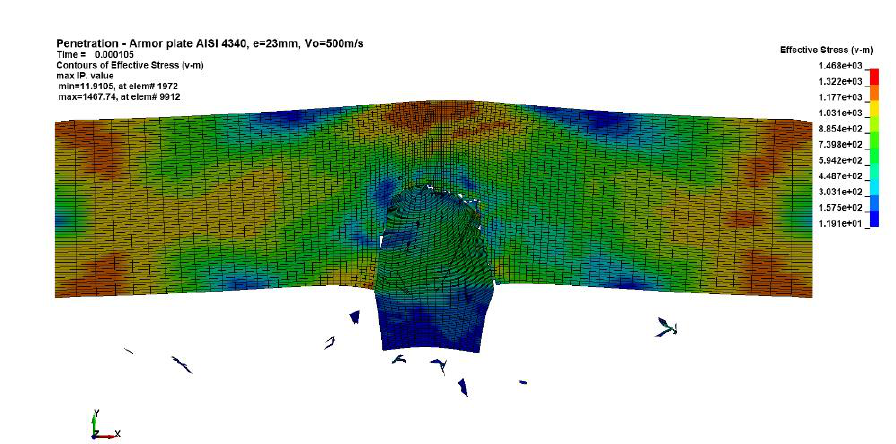
Figure 13 – Von Misses equivalent stress, time of analysis 0.1 ms – Model 2 Рис. 13 – Von Misses эквивалентное напряжение, время анализа 0.1 ms – Модель 2